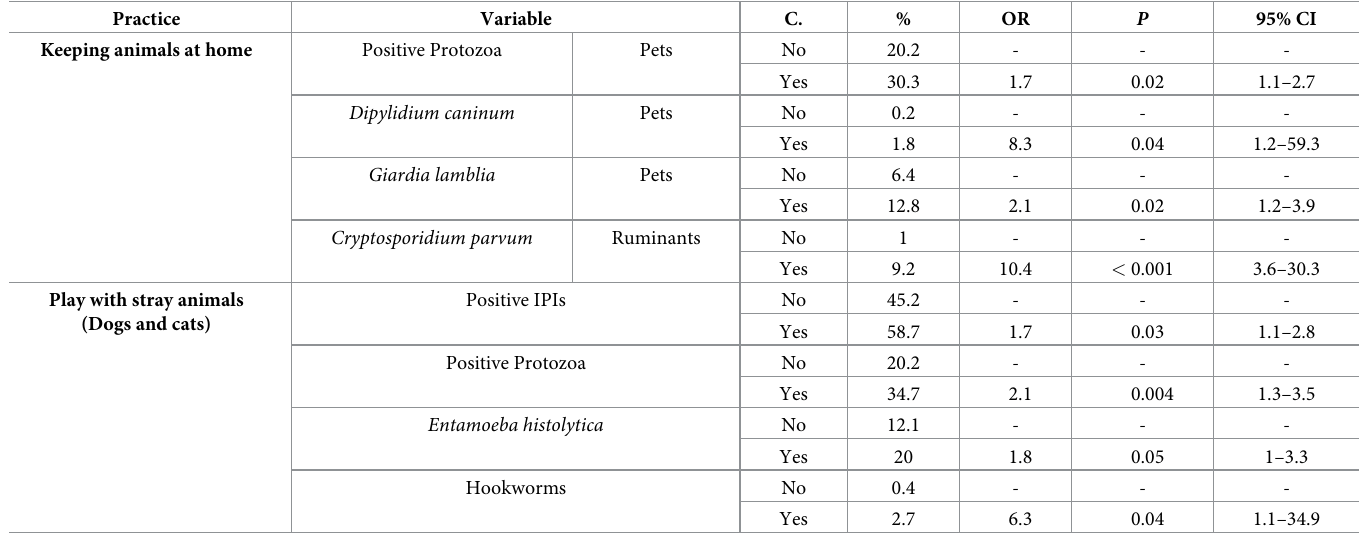
Other variables (e.g. birds and other parasites) had no significant